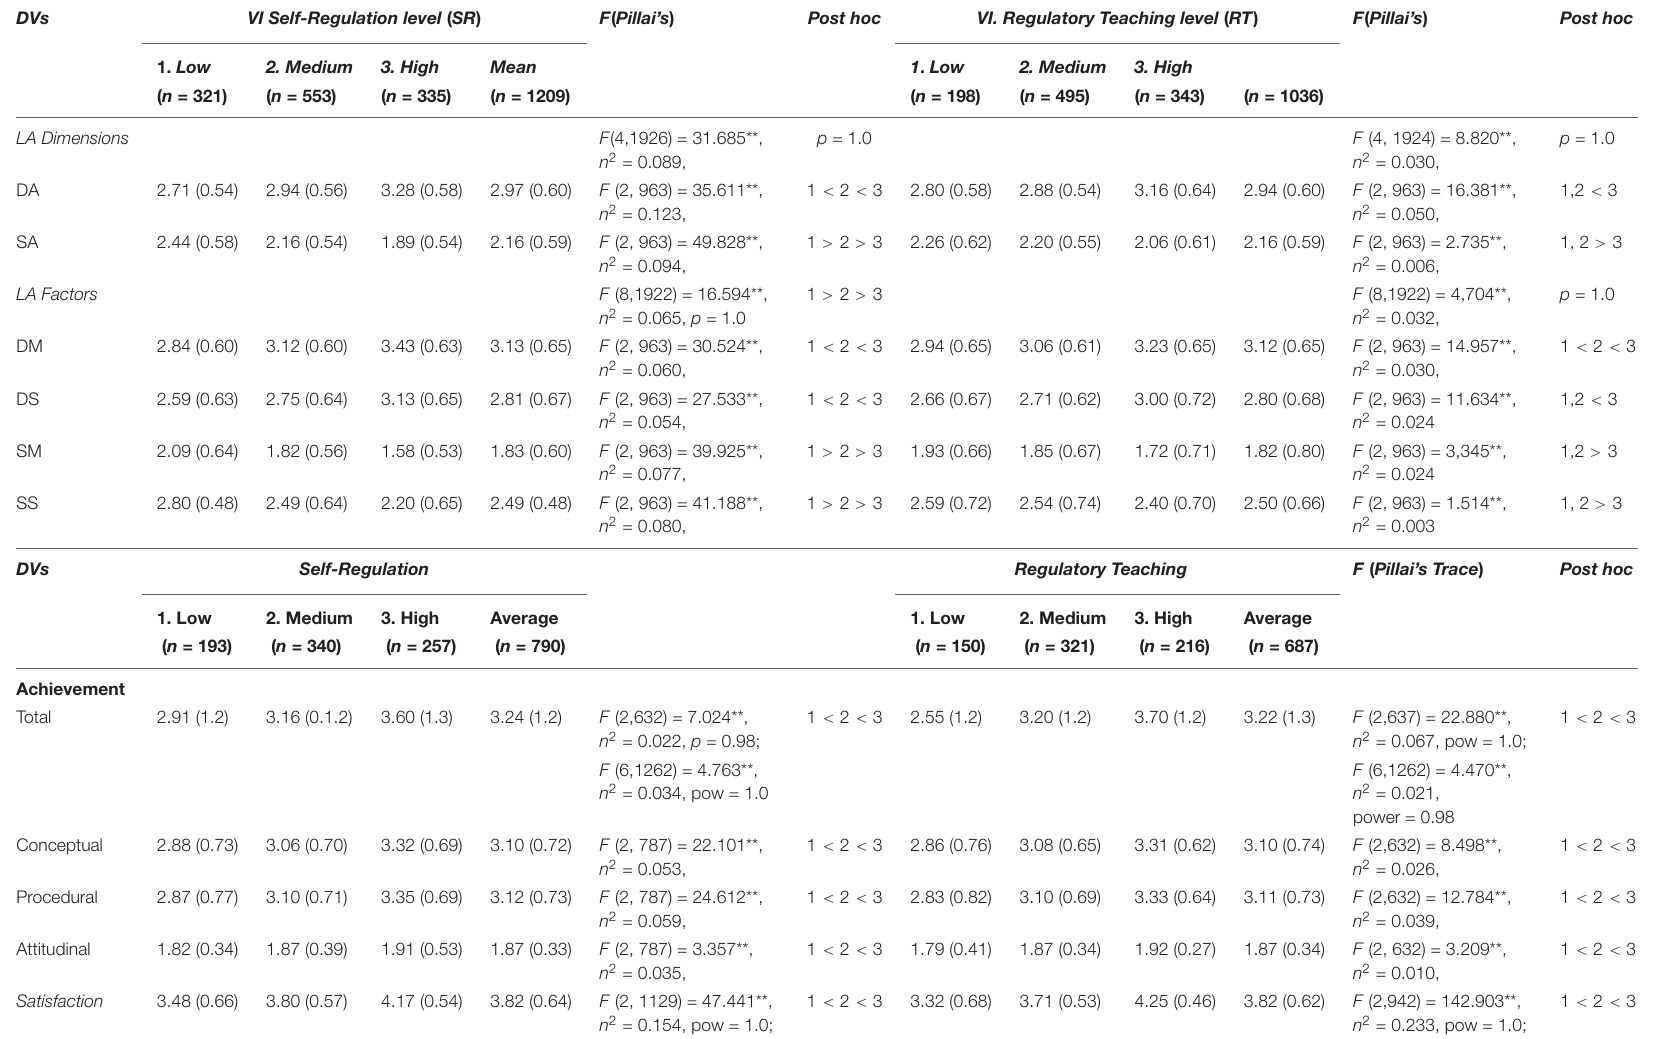
TABLE 2 | Simple interdependent relations of low-medium-high levels of Self-Regulation (SR) and of Regulatory Teaching (RT), as independent variables, on Learning Approaches ( n = 1209).